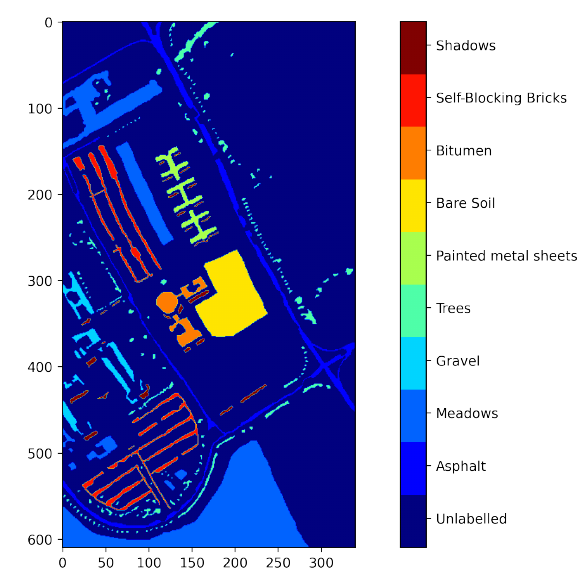
Figure 2: Visualization of the Pavia University ground truth. The image size is 610 x 340 pixels with 103 spectral channels.